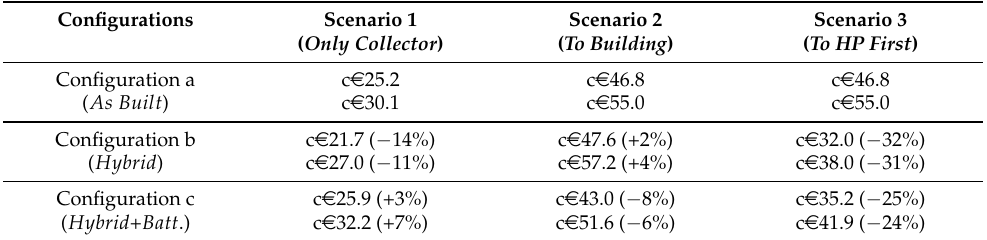
Table 10. Summary of the LCOHs with the different inflation levels (0% on top, 2.5% below).